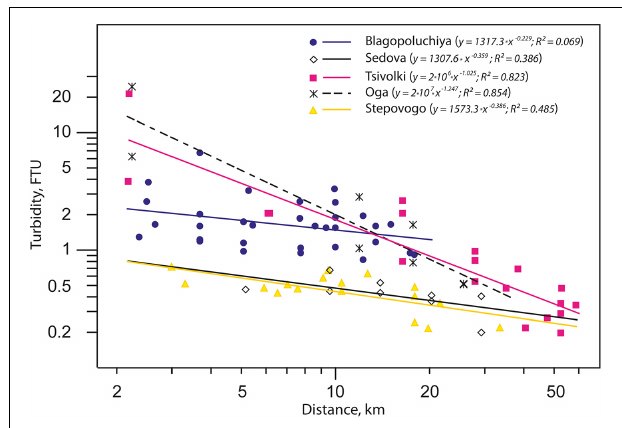
FIGURE 2 | Turbidity distribution in five investigated fjords of the Novaya Zemlya archipelago.